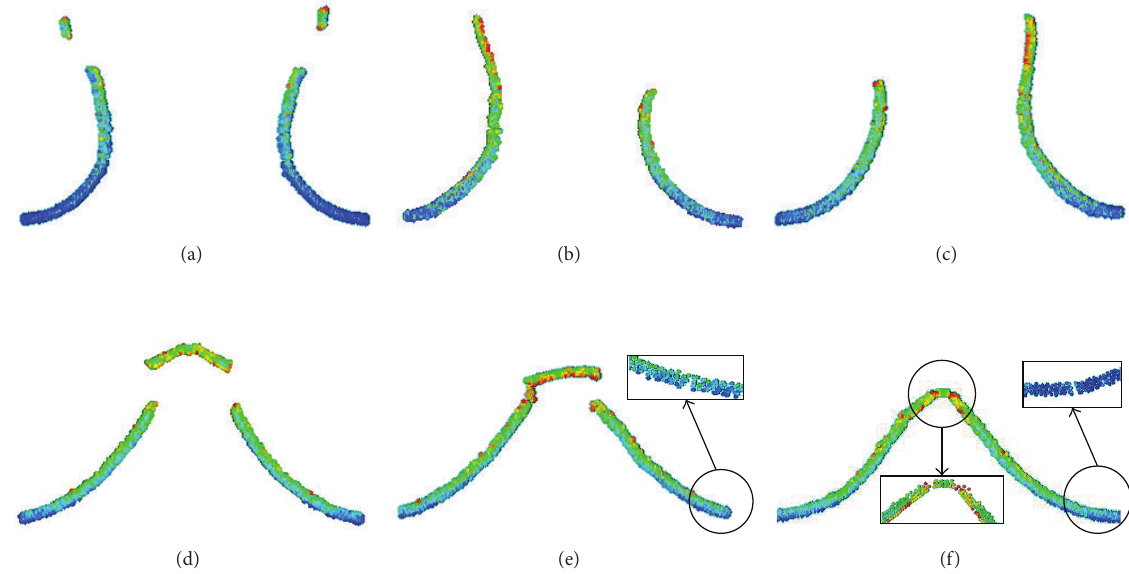
Figure 9: The equivalent plastic strain of different covering thicknesses at about 2 ms; (a)–(f) correspond to the covering thickness of 0,